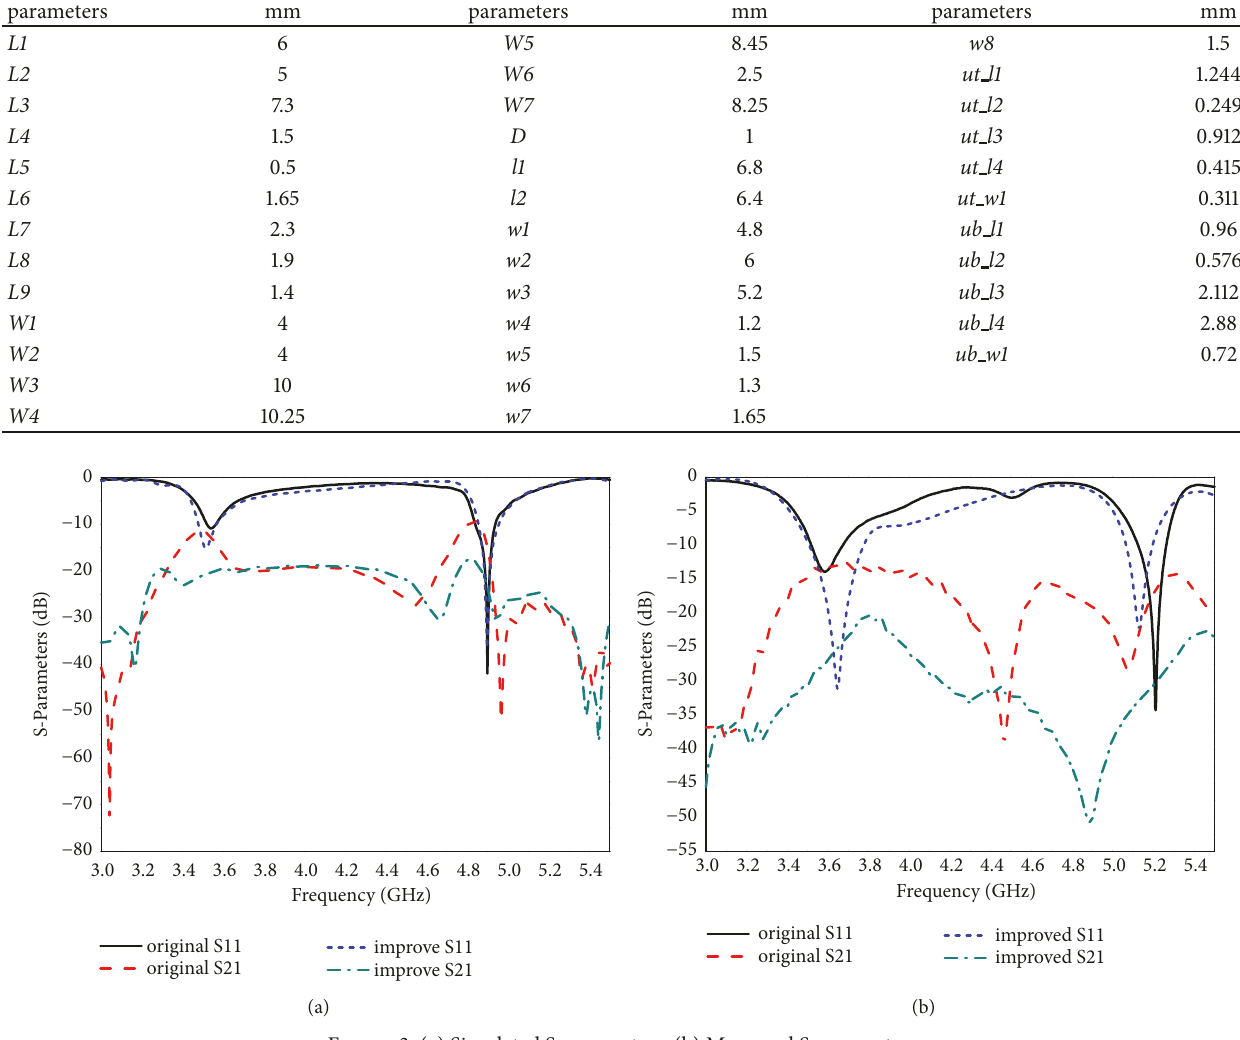
Figure 3: (a) Simulated S-parameters. (b) Measured